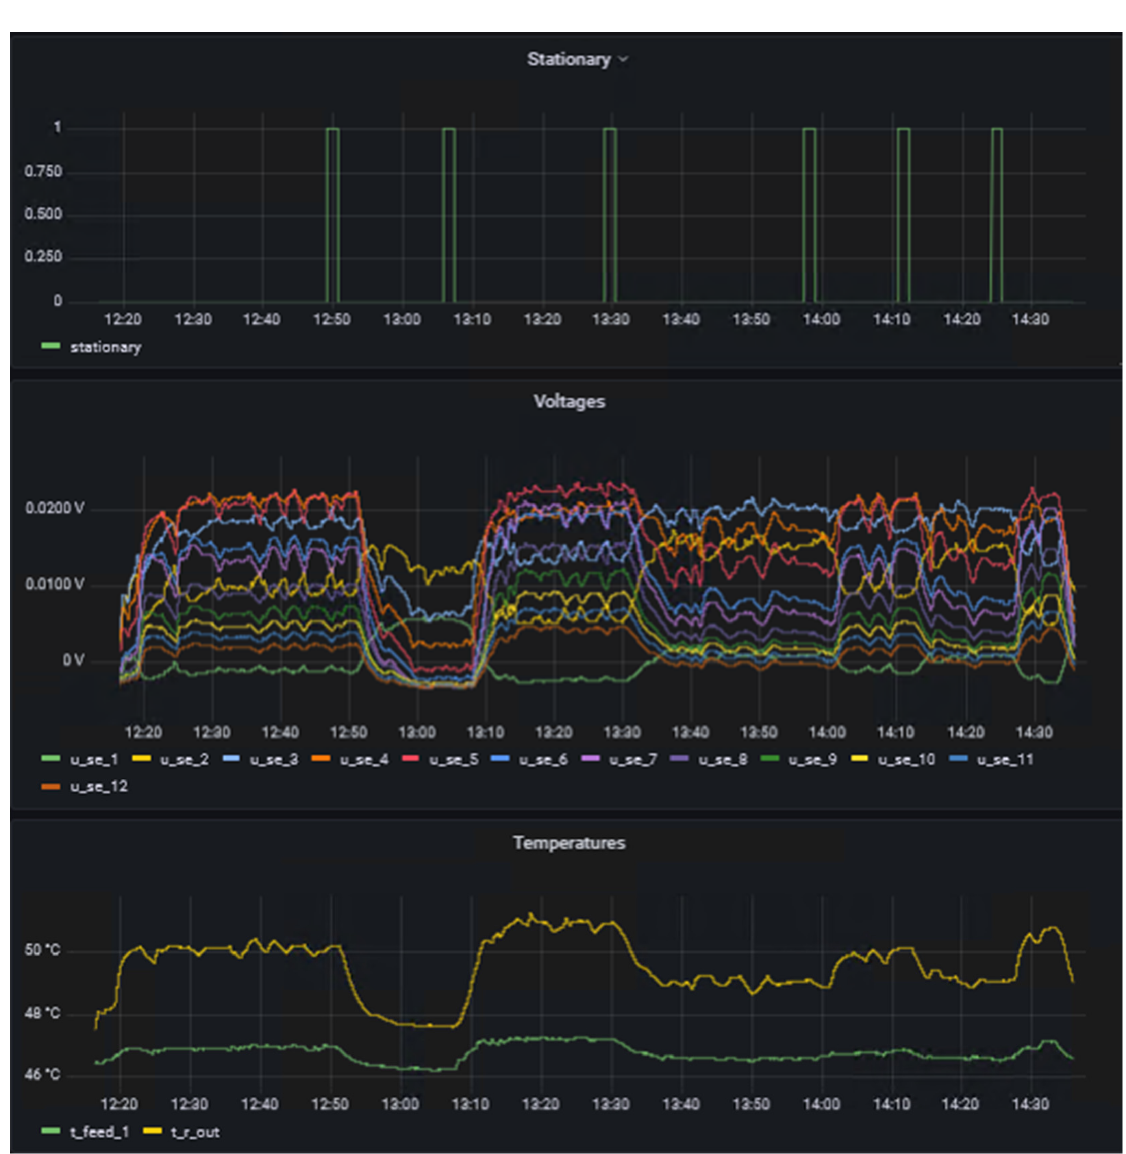
Figure 5. Excerpt from the dashboard during the investigation of the oxidation of thiosulfate with hydrogen peroxide.